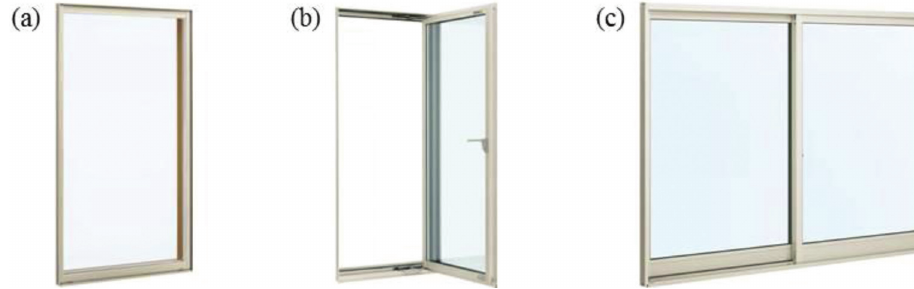
Sketches of the measured window types. (a), (b) and (c) are a fixed window, a projected window and a sliding window, respectively.